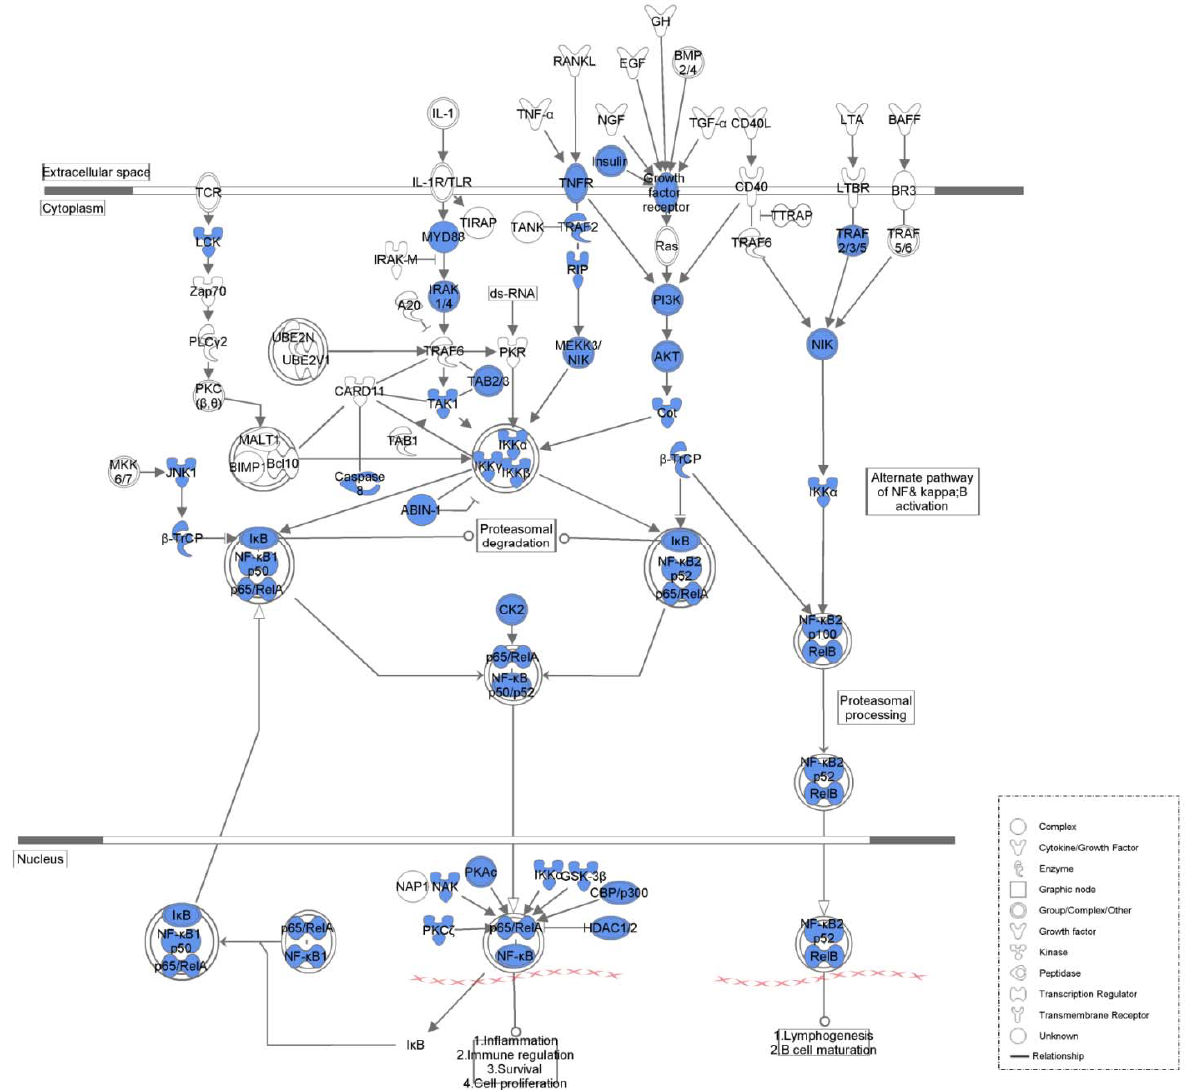
Figure 4. NF-kappaB signaling associated with the common network. Blue legends represent proteins contained in the common